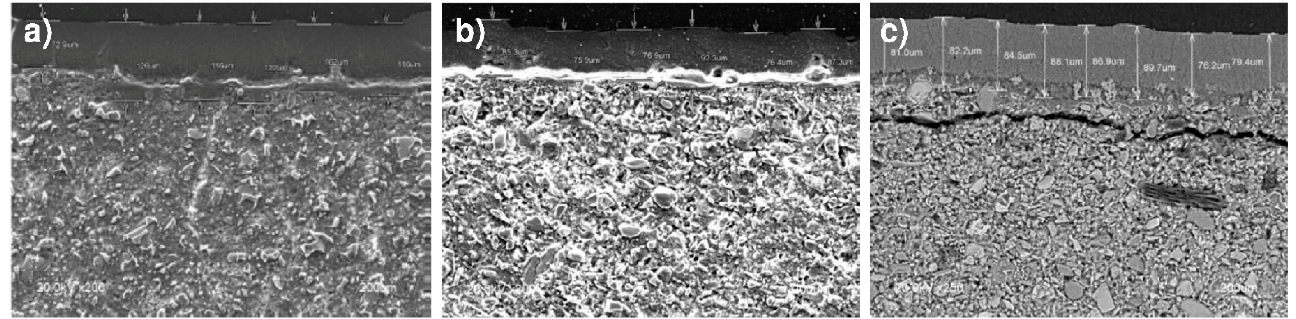
Figure 9. Brucite formation in 56-d seawater-soaked pastes: ( a ) OPC (×200); ( b ) M1 (×200); ( c ) M2 (×250). Plates identified as Friedel’s salt on the grounds of composition (Al, Cl and Ca) and morphology [60,65] were observed in the 56-d pastes exposed to 0.5 M NaCl (Figure 10).